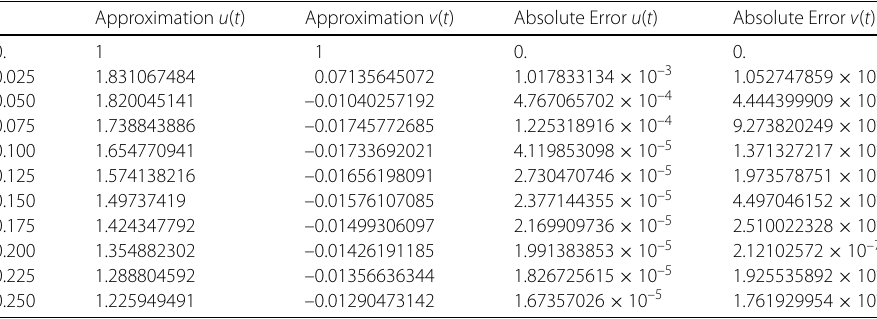
Table 2 Numerical results of the RK solutions at different values of t of Example